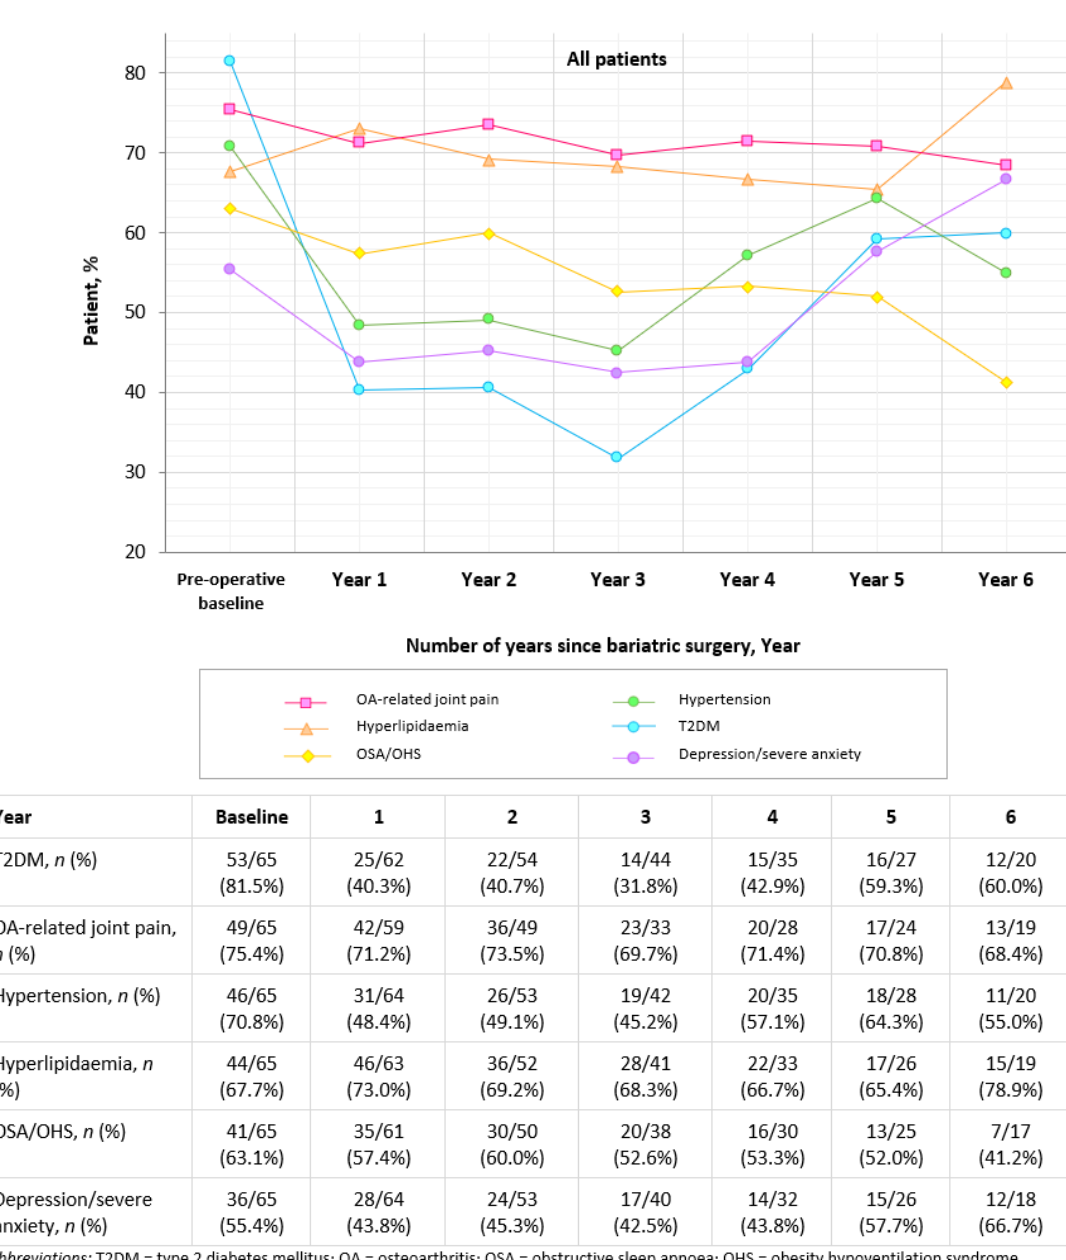
Figure 2. Prevalence of obesity-related comorbidities preoperatively and at 1 – 6 years following bariatric surgery (%).